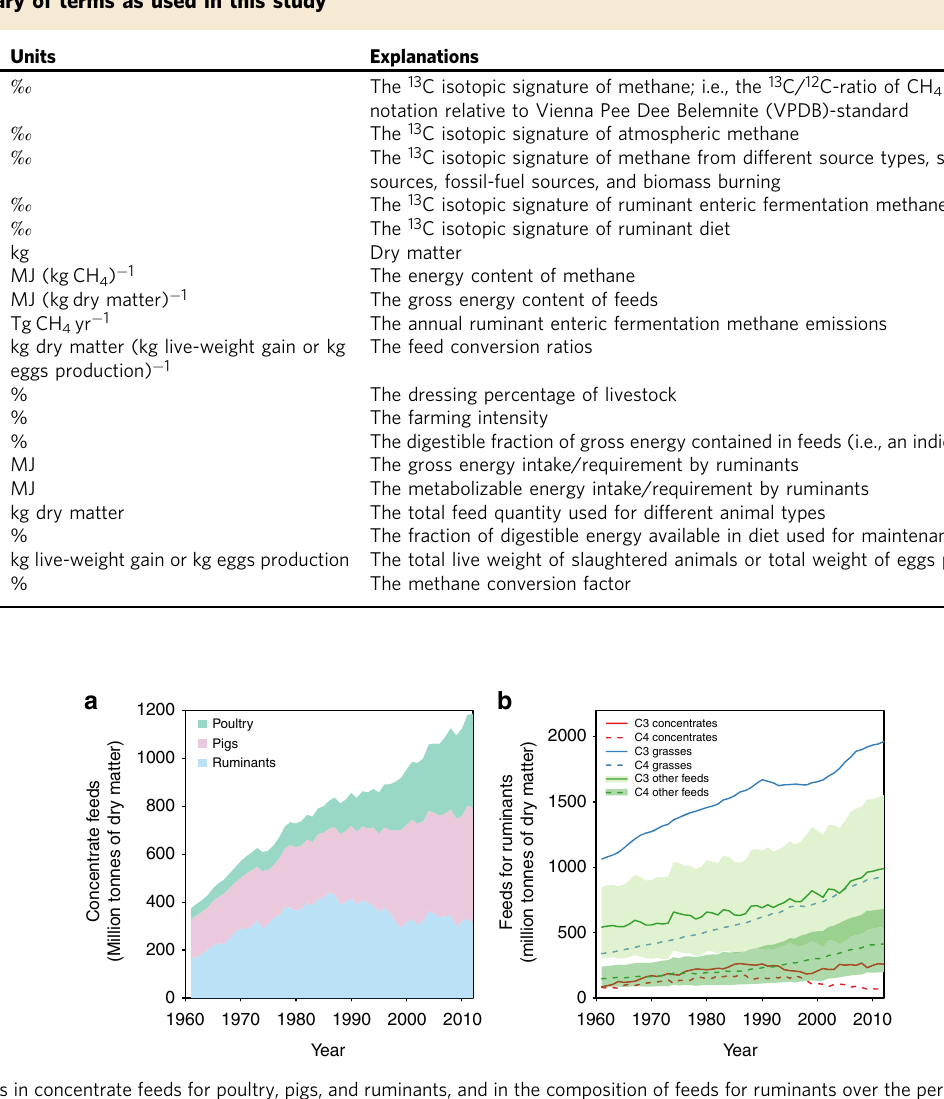
Table 1 Glossary of terms as used in this study